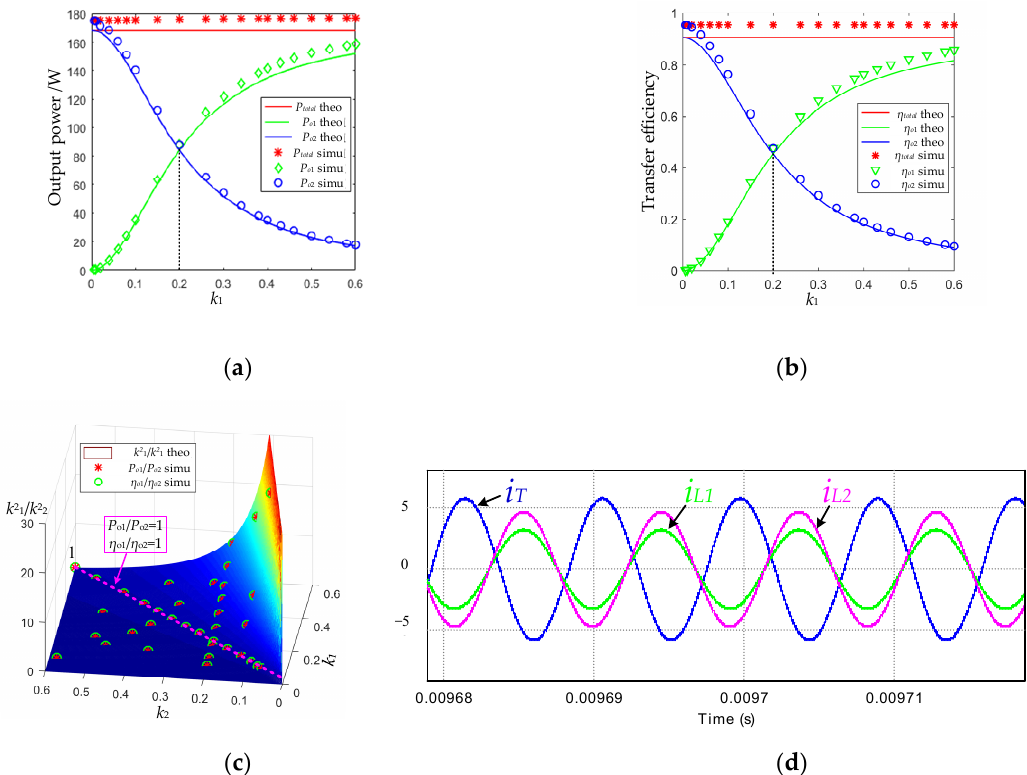
Figure 13. Power distribution and efficiency distribution when k 1 ≠ k 2 : ( a ) power distribution; ( b ) efficiency distribution; ( c ) waveform of input and output current when k 1 ≠ k 2 , and k 1 = 0.1, k 2 = 0.2. Table 3. Comparison of multi-load WPT systems.